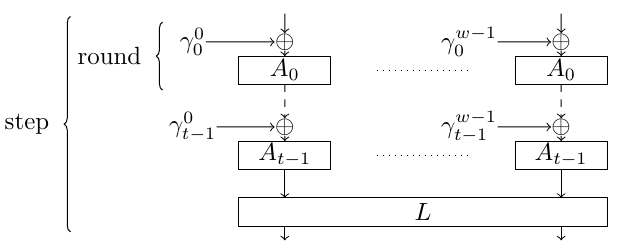
Figure 6: The overall structure of a step for the long trail strategy. The wires correspond to branches which, in our case, are divided into two words